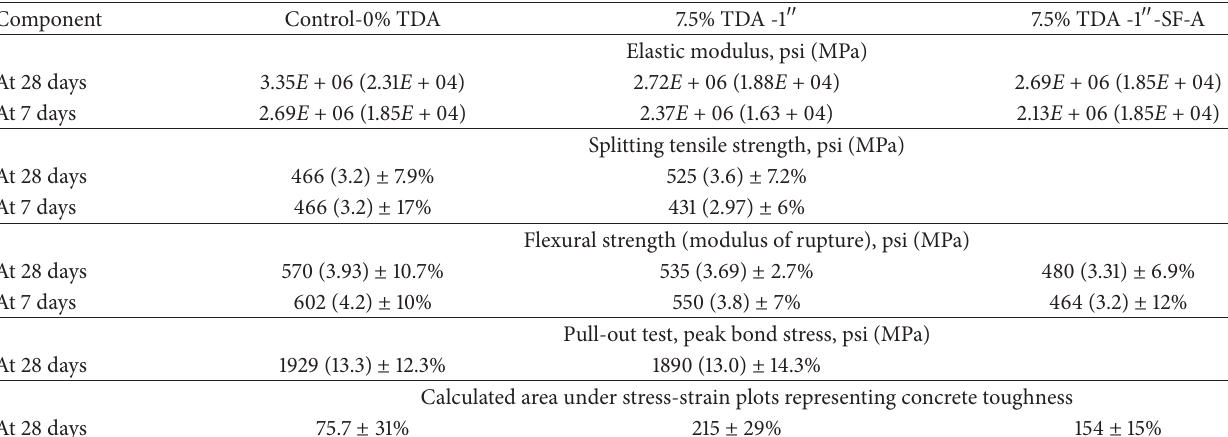
Table 5: Calculated elastic modulus, splitting tensile strength, flexural strength, peak bond stress, and calculated area under stress-strain plots for the control and TDA concrete with and without silica